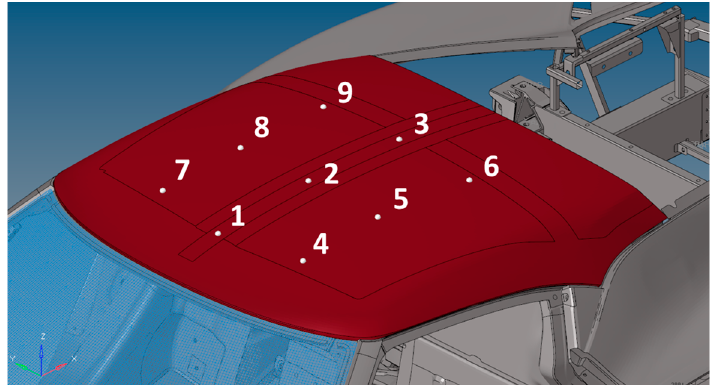
Figure 11 . Monitoring point on the pavilion of 4C car. Figure 11. Monitoring point on the pavilion of 4C car.